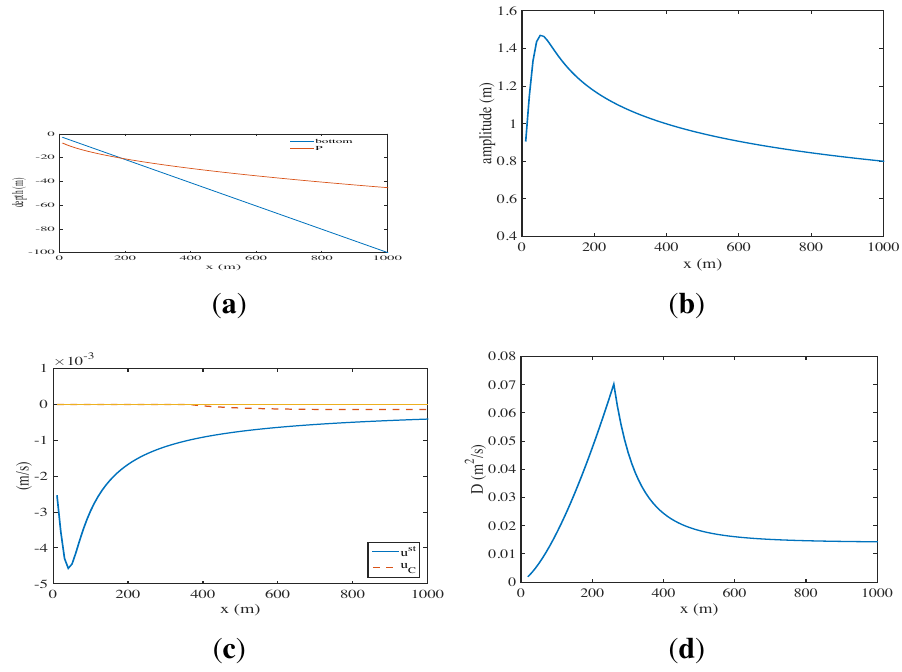
Figure 8. ( a ) Bottom topography h ( x ) and P ( x ) ; ( b ) wave amplitude A ( x ) ; ( c ) oil slick velocity u st and subsurface oil velocity u